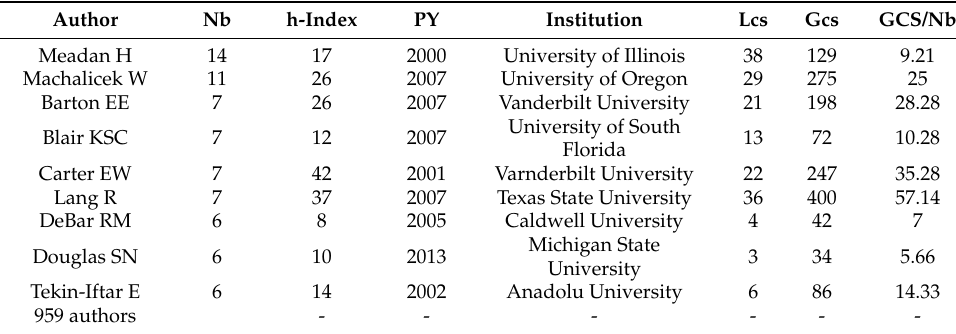
Table 2. Authors with the highest number of